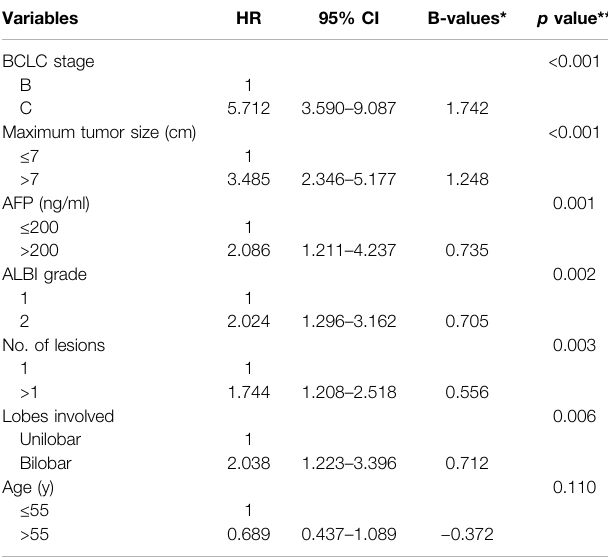
TABLE 2 | Univariate analysis of risk factors associated with one-year disease control.